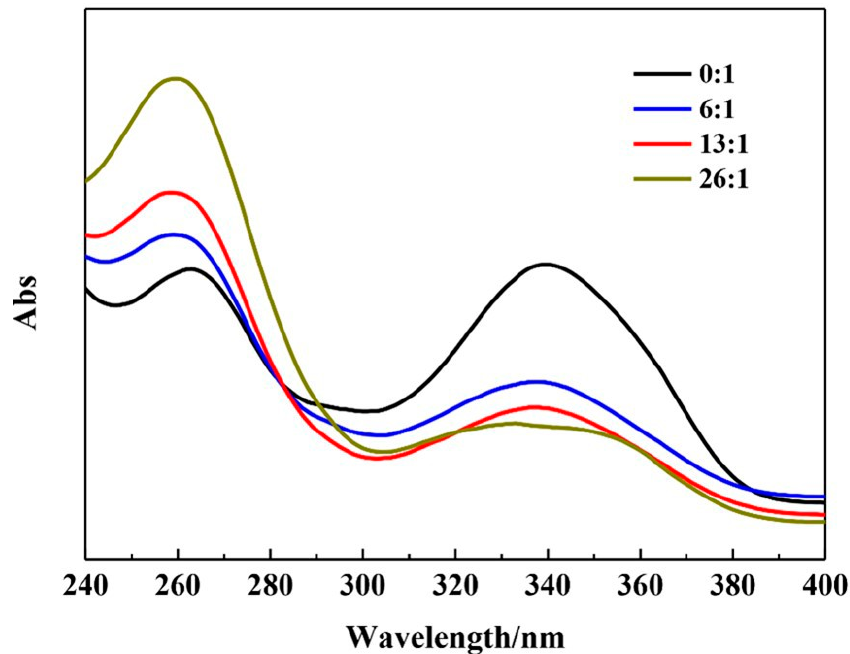
Figure 5. UV absorption spectra of different concentrations of RNA–OTMA mixed with Eu (TTA) 3 (H 2 O) 2 Eu (TTA) 3 (H 2 O) 2 : RNA–OTMA = 0:1, 6:1, 13:1 and 26:1complexes dissolved in butanol so- lution.